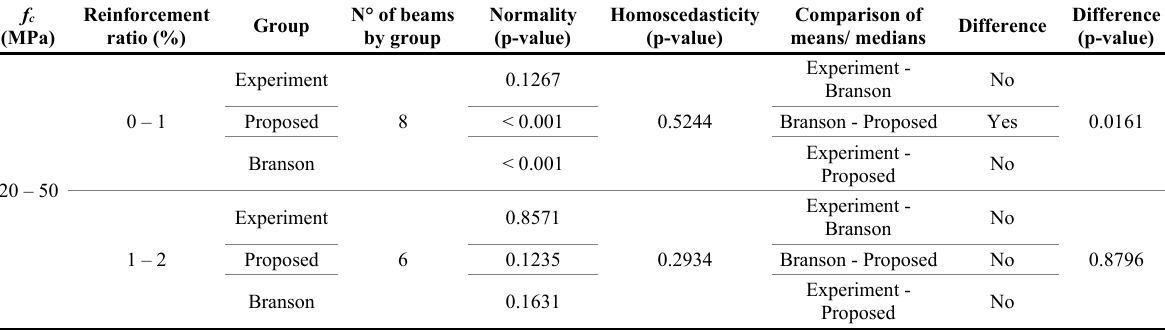
Table 1. Beams analysis with f c from 20 to 50 MPa with reinforcement rate from 0 to 1% and reinforcement rate from 1% to 2%.